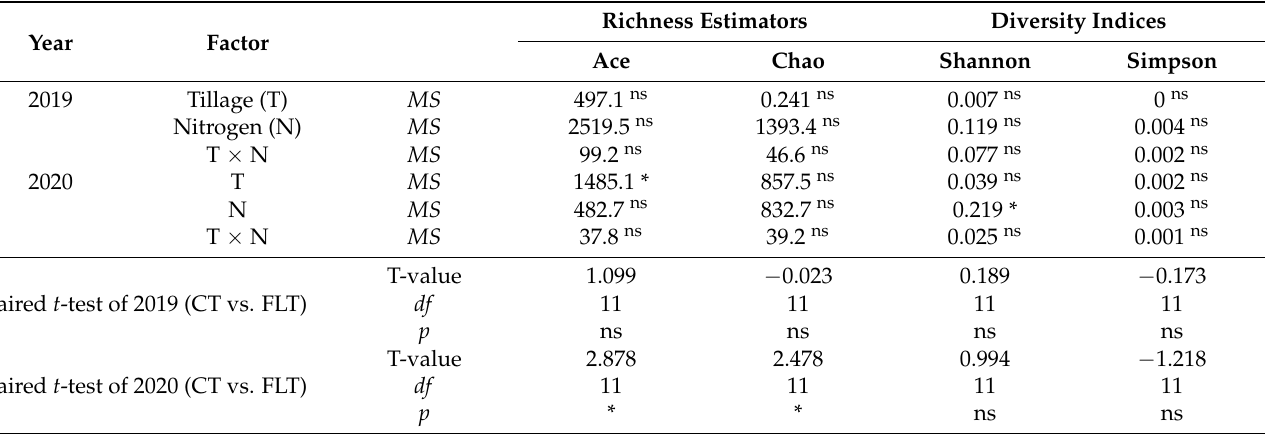
Note: MS represents mean square; * represents a significant difference at the 0.05 level; ns represents no significant difference. CT, conventional tillage; FLT, Fenlong